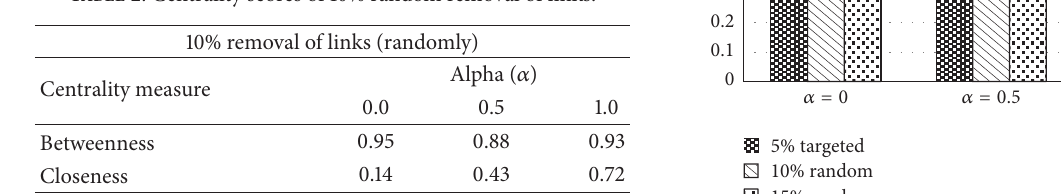
Table 2: Centrality scores of 10% random removal of links.